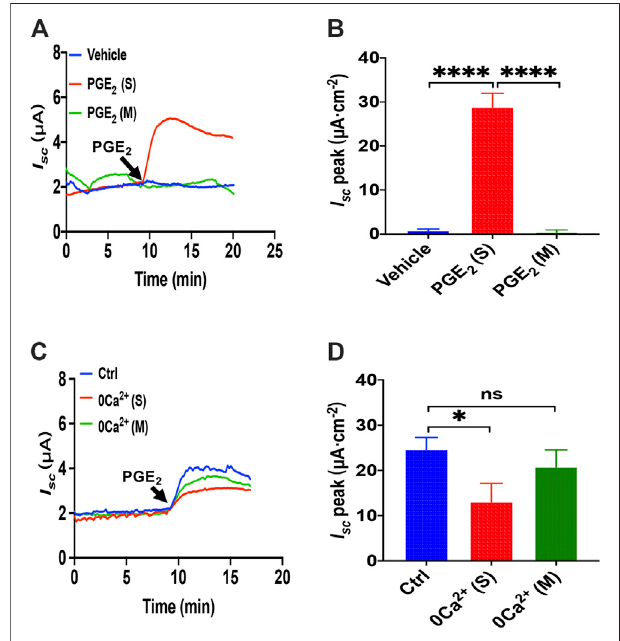
FIGURE 1 | PGE 2 induced Ca 2+ -dependent small intestine epithelial anion secretion. (A) Time courses of PGE 2 (10 μ M) -evoked I sc or vehicle (DMSO) when applied to the serosal (s) or mucosal (m) side of mice duodenal mucosal tissues ( n ≥ 6). (B) When added to the serosal or mucosal side, vehicle or PGE 2 -stimulated I sc peak ( n (cid:2) 6). (C) Time courses of PGE 2 -evoked I sc after extracellular Ca 2+ omission (0 Ca 2+ ) from each side in duodenal mucosal tissues. (D) PGE 2 -stimulated I sc peak after Ca 2+ omission from each side ( n ≥ 6). Ctrl represents as the control in which normal extracellular Ca 2+ was on both sides. Results are presented as mean ± SE. * p < 0.05, **** p < 0.0001, signi fi cantly different from the corresponding control by one-way ANOVA followed by Dunnett ’ s